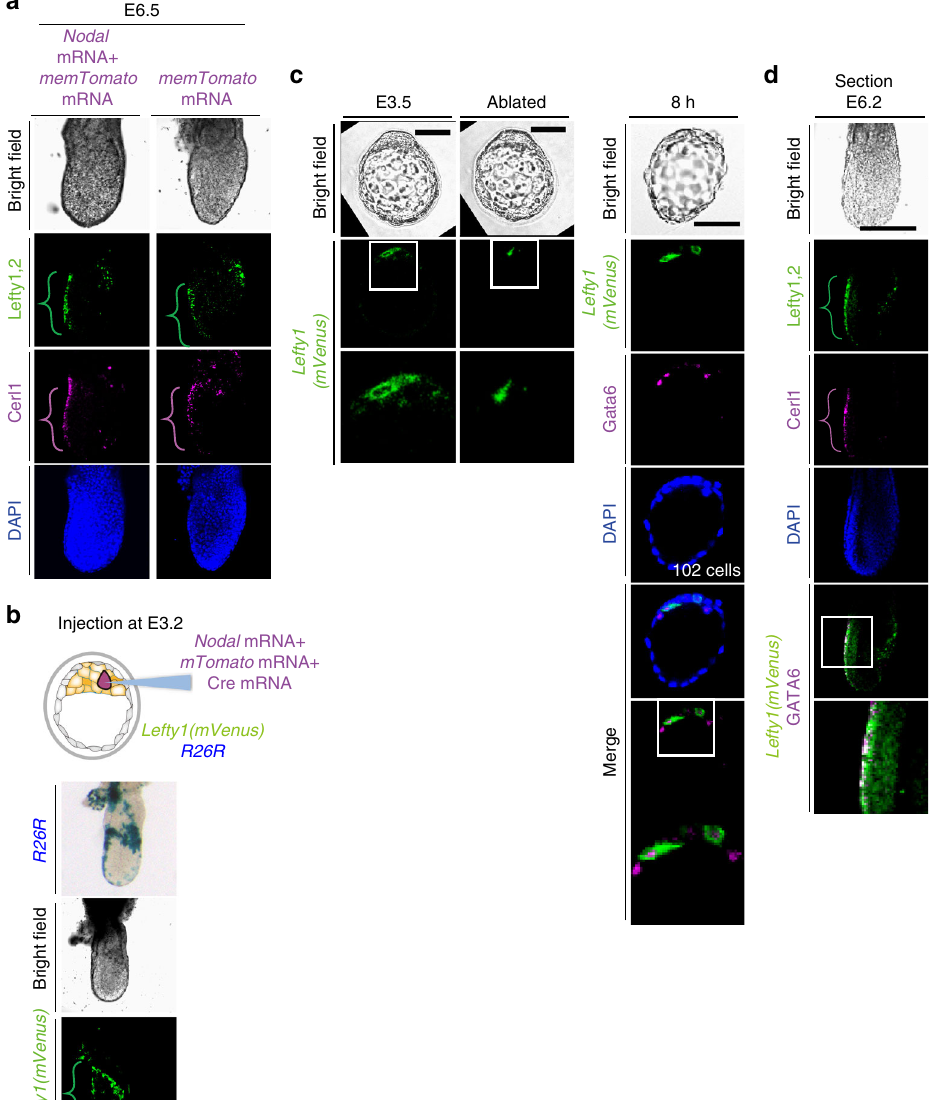
require investigation of the origin and regulation of Nodal activity during earlier stages.